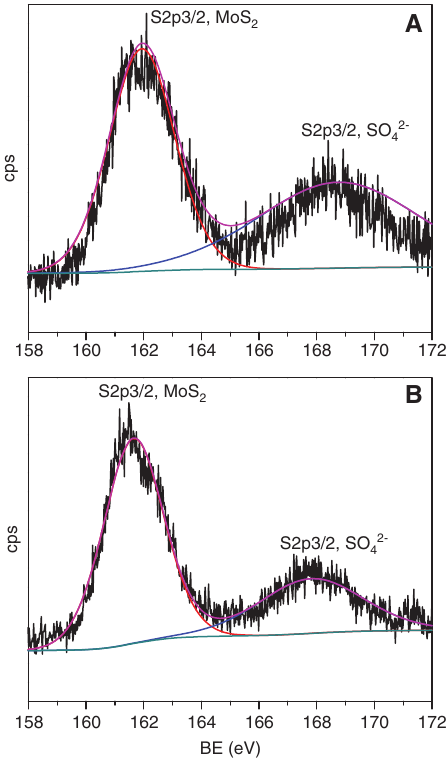
Figure 7: XPS spectra of Mo3d level for nanospheres (A) NiMoS (B) CoMoS . 2